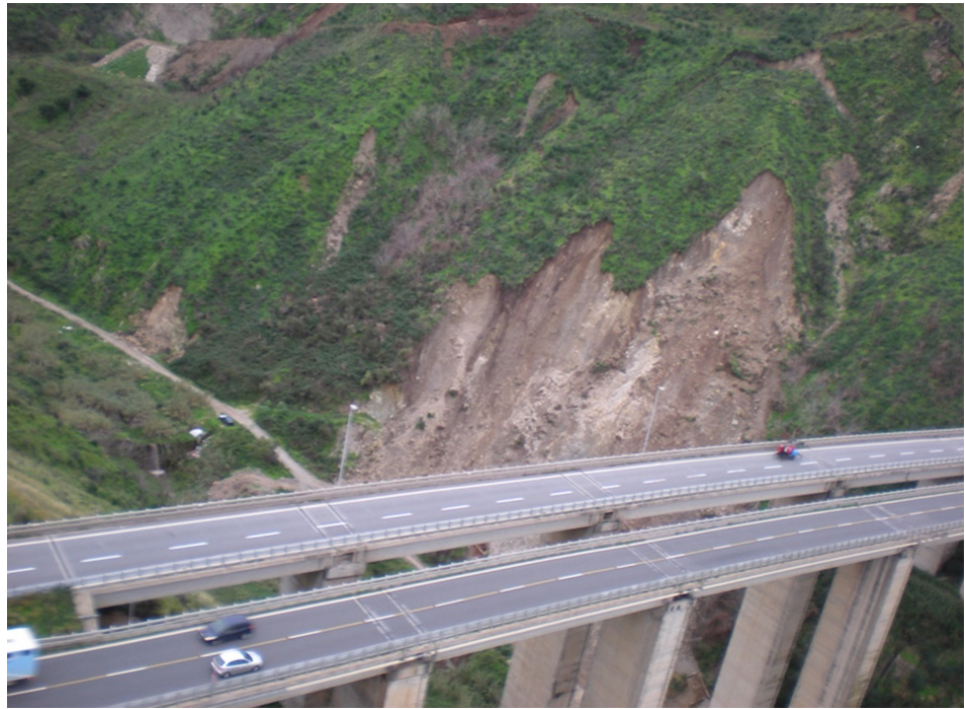
Fig. 2. Picture of Santa Trada landslide nearby the viaduct of the A3